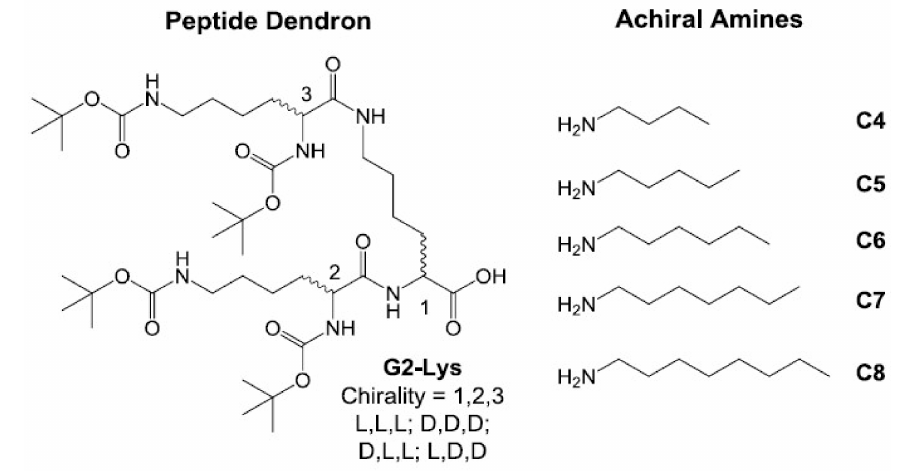
Figure 1. Two-component self-assembling system investigated in the first part of this